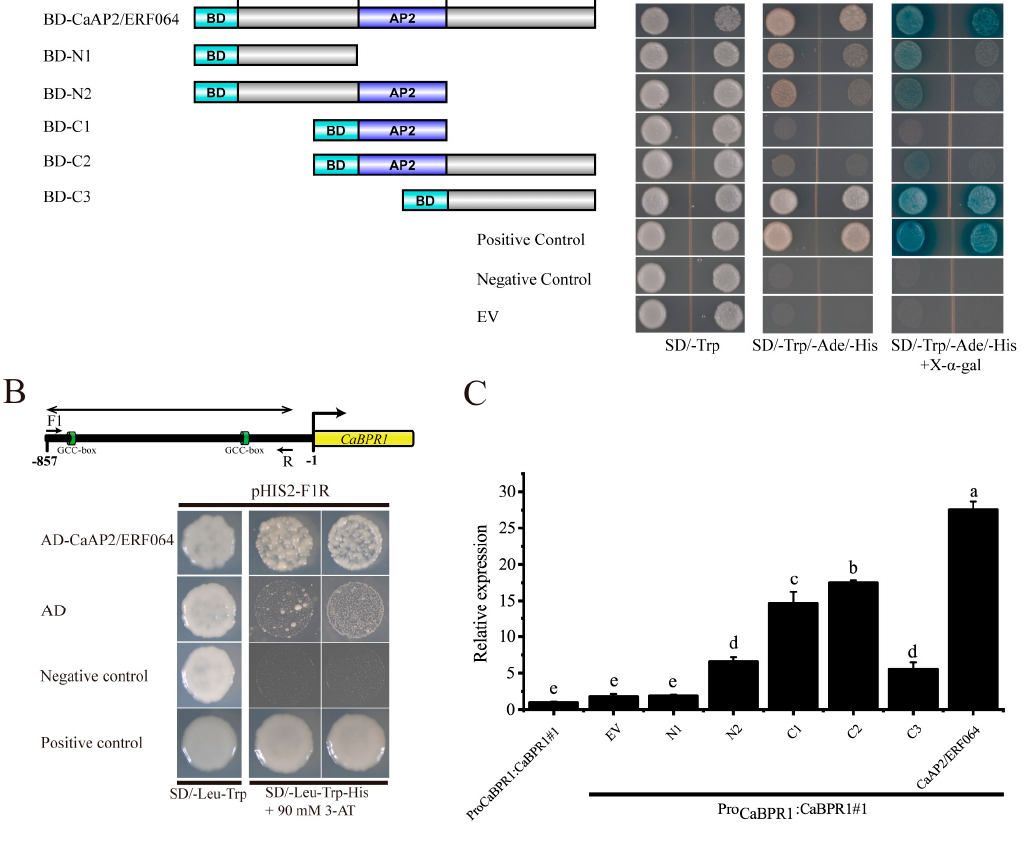
Figure 4. CaAP2 / ERF064 promotes the transcription of CaBPR1 . ( A ) Transcriptional activation of CaAP2 / ERF064 in yeast. ( B ) Interaction of CaAP2 / ERF064 and the promoter fragments (F1R) of CaBPR1 in yeast. ( C ) Expression analysis of CaBPR1 in Pro CaBPR1 :CaBPR1 transgenic tobacco plants after infiltration of CaAP2 / ERF064 and its deletion mutants. Values are means ± SD. Small letters indicate a significant difference (LSD, p < 0.05).